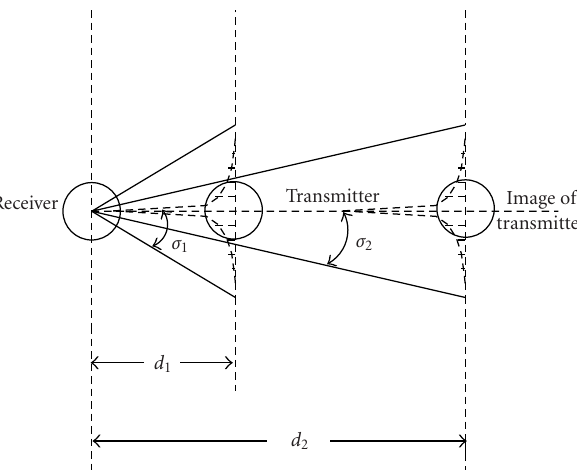
Figure 4: Angular spread of transmitter and its image as perceived by the receiver. The circles are visualizations of the receiver, the transmitter, and the image of the transmitter. Using basic geome- try, the width of the angular spread is calculated using a spread and a distance reference value. In this case d 1 and σ 1 are the referenced values, d 2 is a known value, and σ 2 is the resulted calculated